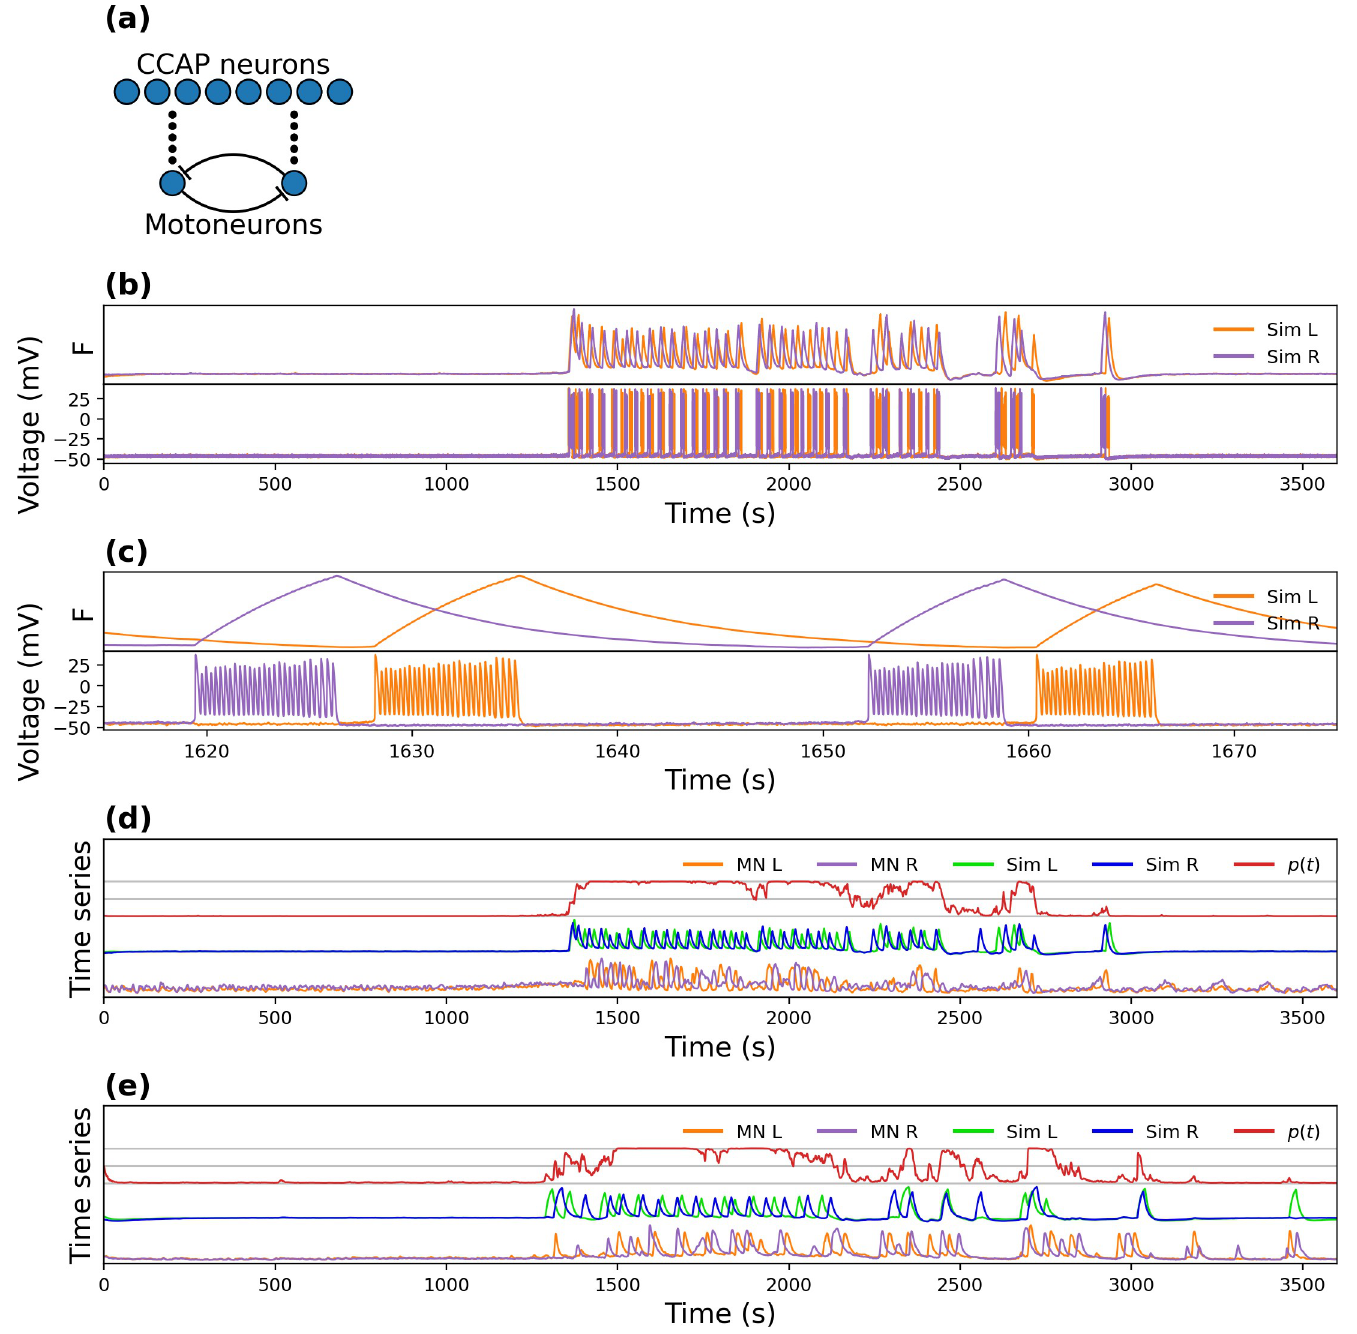
Fig 7. Simulation of fluorescence spikes. (a) Model circuit structure, showing the 8 α CCAP neurons that release the peptidergic signal (black circles) and activate the antiphase oscillatory behavior of the left and right motoneurons. (b) Simulated fluorescence (top) and voltage (bottom) time series of left (“Sim L”) and right (“Sim R”) motoneurons. (c) Magnification of a small segment of (b). (d, e) Simulation of two different experiments. The gray grid marks probabilities of 0, 0.5 and 1. “MN L”, “MN R”, “Sim L” and “Sim R” indicate experimental left, experimental right, simulated left, and simulated right motoneurons, respectively. p ( t ) indicates the probability of